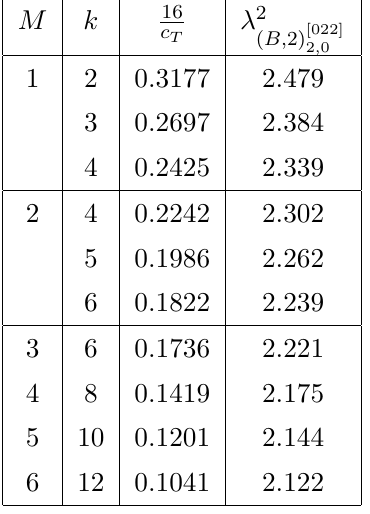
and λ 2 in various U(2) k × U( M + 2) − k ABJ c T ( B, 2) [022] 2 , 0